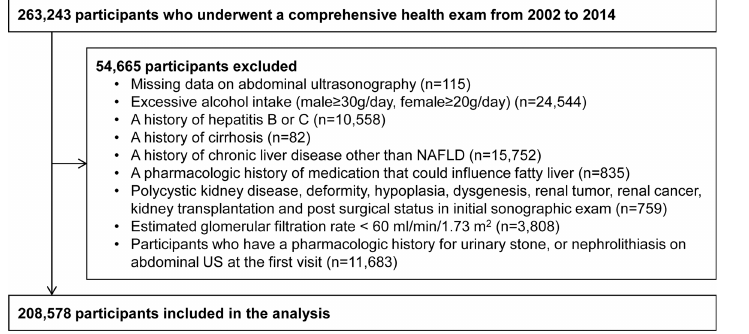
Fig 1. Flow-chart of the included